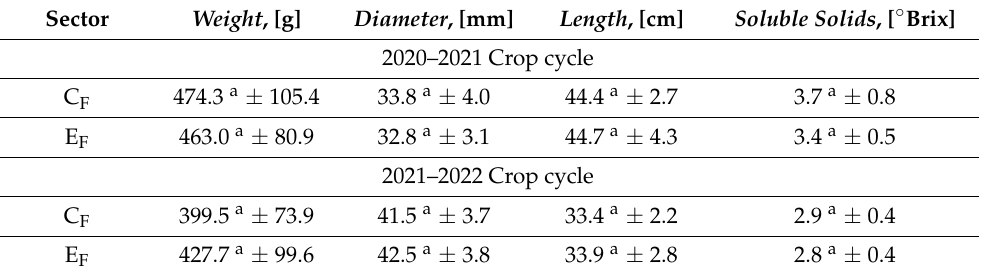
Table 4. Average values of production quality parameters, measured for plants grown in areas with different cover